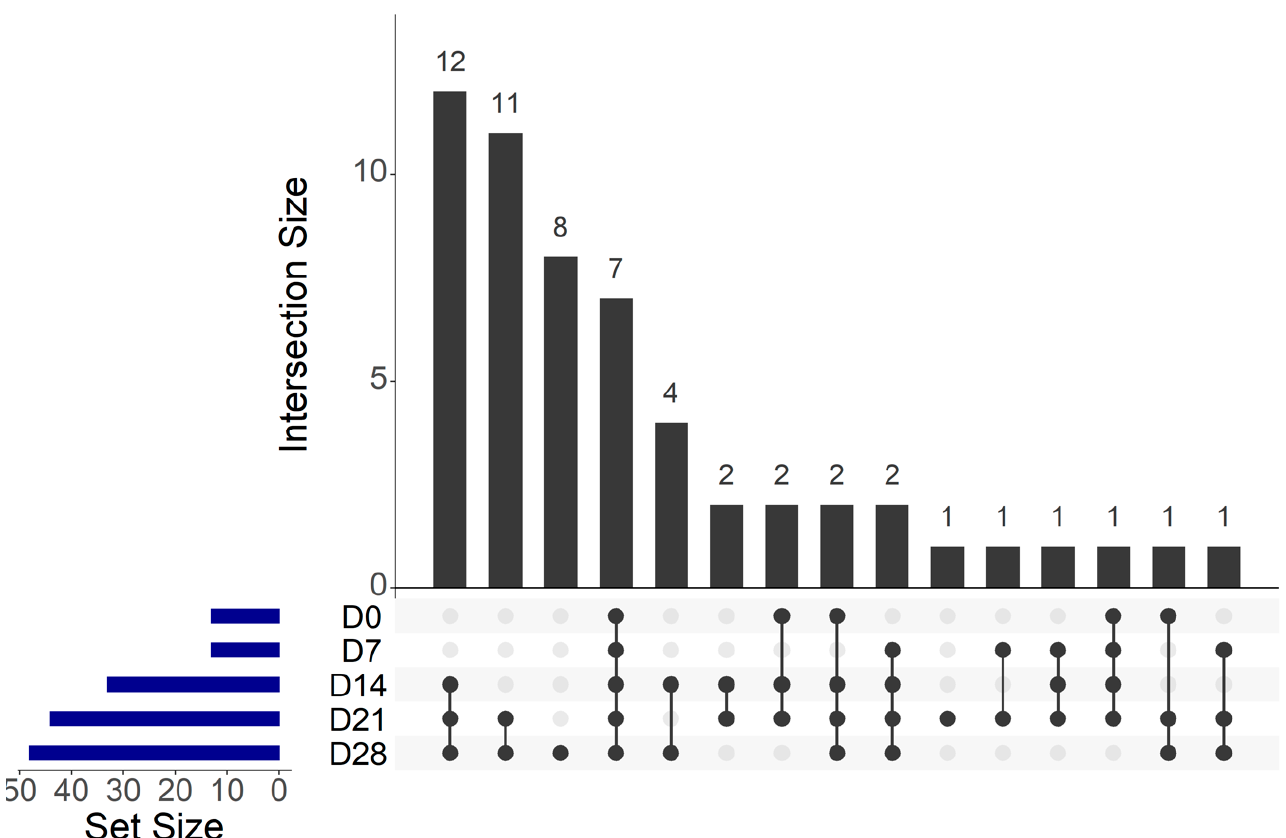
Figure 6. UpSet plot of shared operational taxonomic units (OTUs) identified within cold-smoked salmon vacuum-packed products during 28 days of storage.